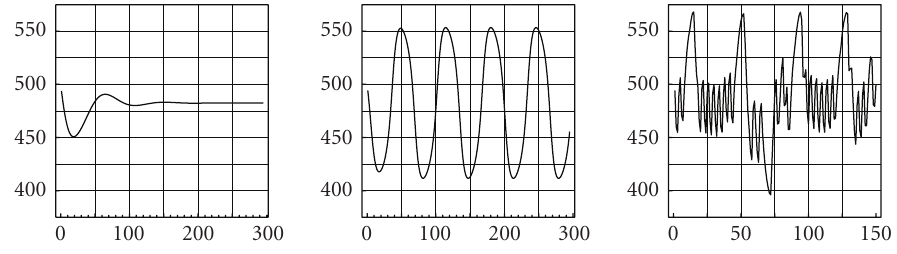
Figure 6.5. Time paths of capital stock K for β = 0 . 8 and α = 0 . 03,0 . 05,2 .